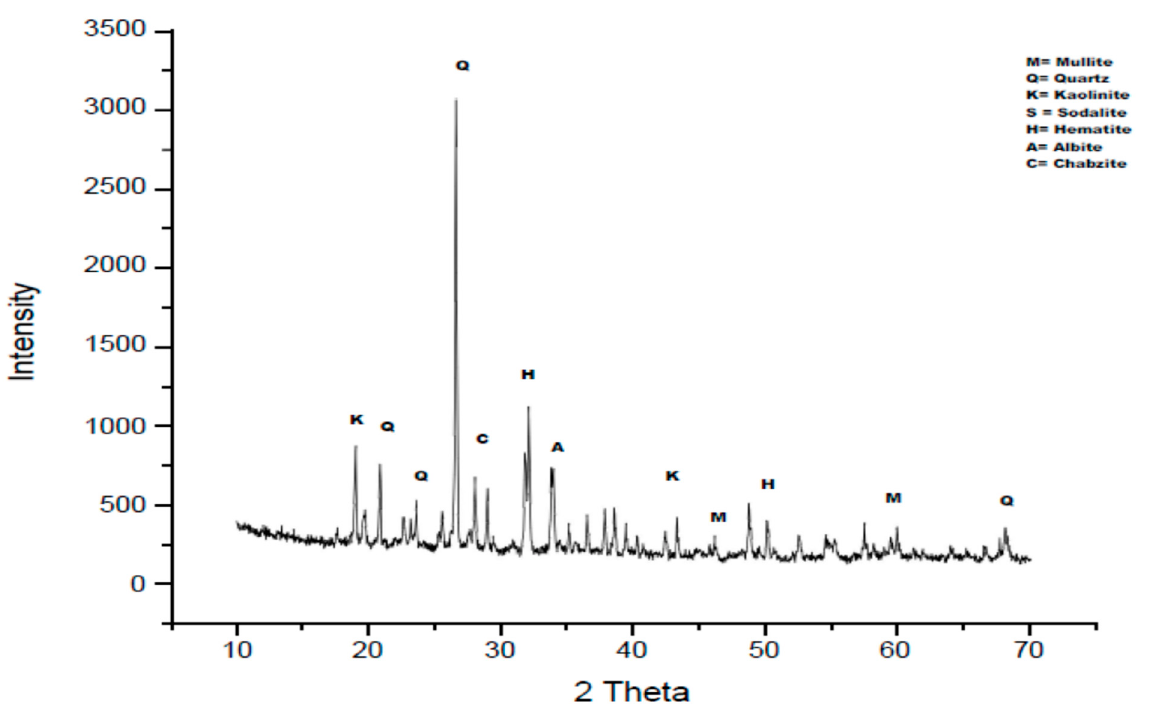
Figure 8. XRD pattern of geopolymer prepared at optimum conditions.